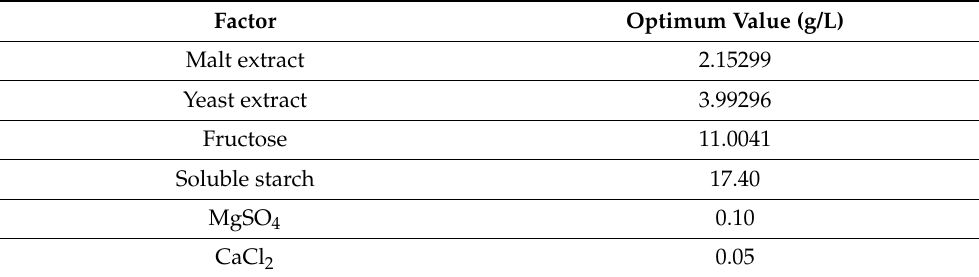
Table 5. Optimized concentrations of broth components for dry mycelium yield.